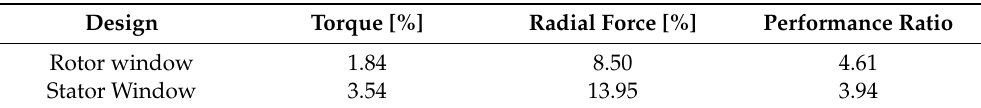
Table 11. Comparison of static torque and radial force reduction when a circular window is located on the rotor or